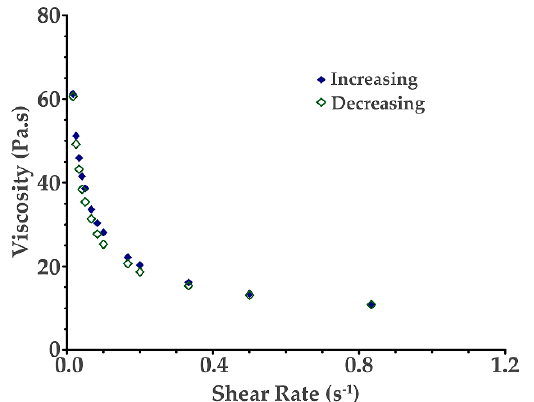
Figure 7. Viscosity as a function of shear rate for the chitosan − starch (2.5 wt% chitosan and 13 wt% starch) hydrogel .